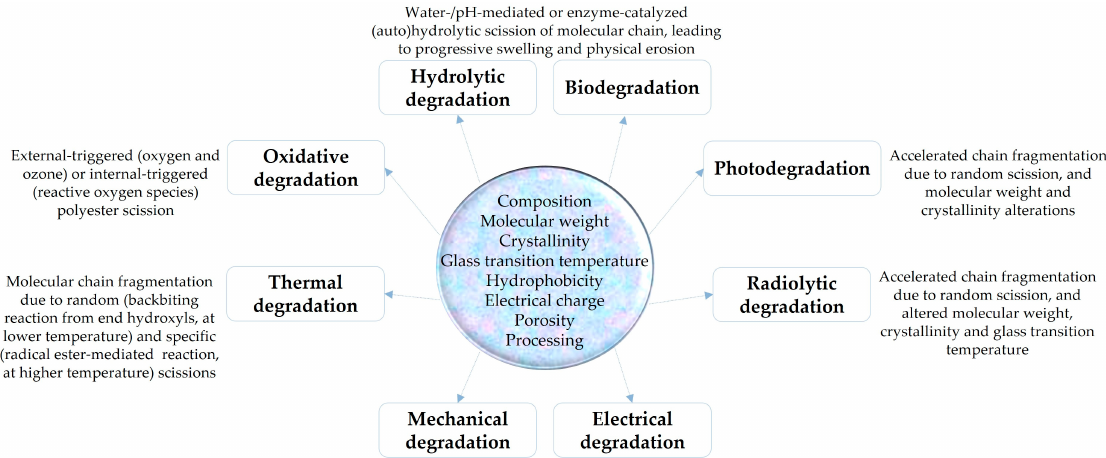
Figure 2. Schematic representation of degradation mechanisms in biopolyester-based formula- tions.